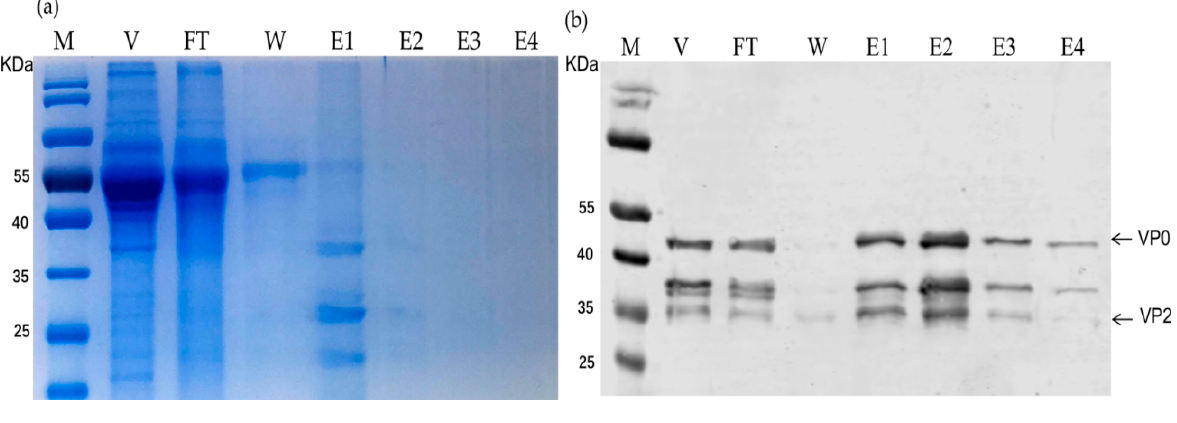
Figure 4. SDS-PAGE and Western blot (WB) analysis of the purified rSVA-His. ( a ) Coomassie Blue- staining of SDS gel to detect the purity of rSVA-His purified in a Ni-NTA column. ( b ) Fractions eluted from the column were analyzed by WB using a monoclonal antibody against SVA capsid protein. Lanes: M, marker; V, crude lysates; FT, flow-through fraction; W, washing fraction; E1 to E4, elution fractions.